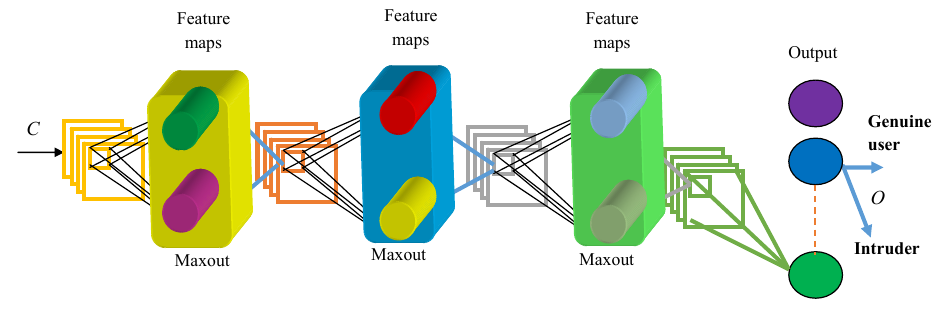
Figure 3. Structure of the DMN.